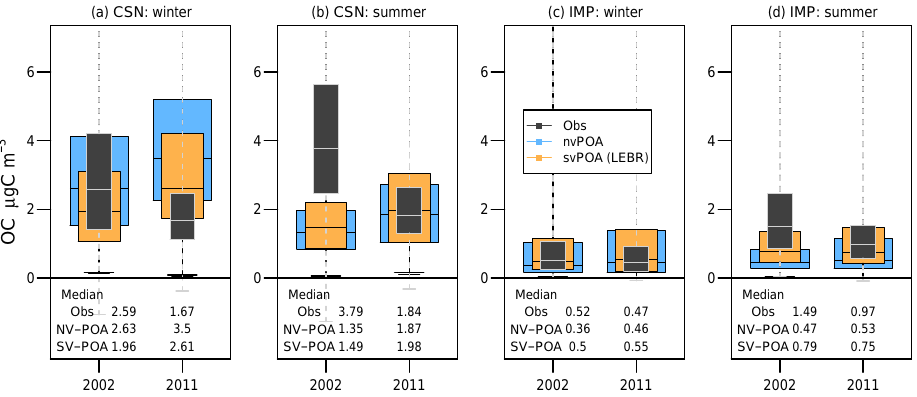
Figure 12. Organic carbon (OC) distributions for routine-monitoring stations and model predictions at the same locations and times. The meaning of the boxes and whiskers is explained in Fig.